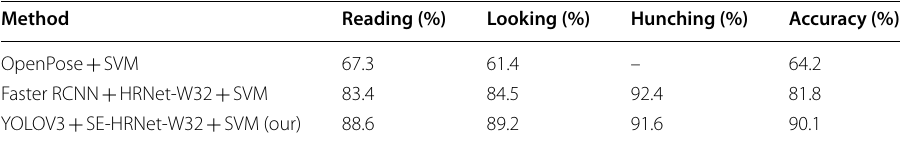
Table 2 Comparisons of different methods on the proposed dataset